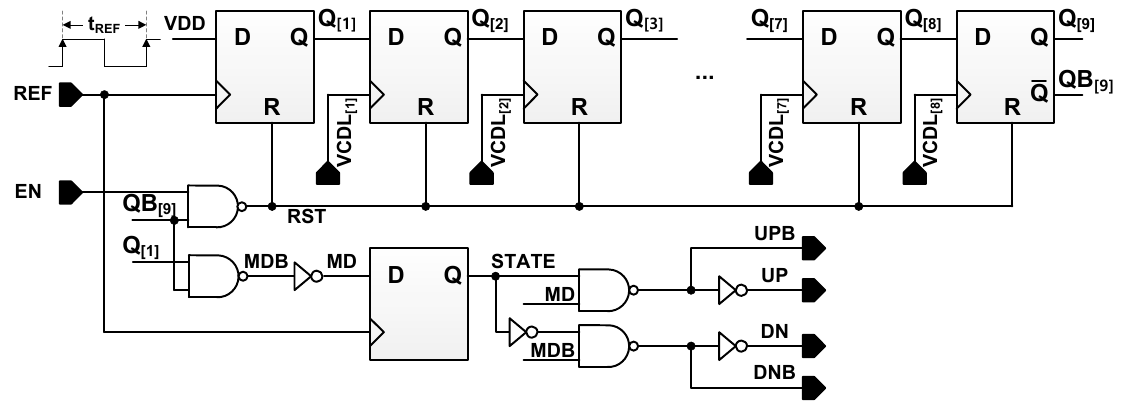
Figure 4. Proposed PD-MDV schematic.